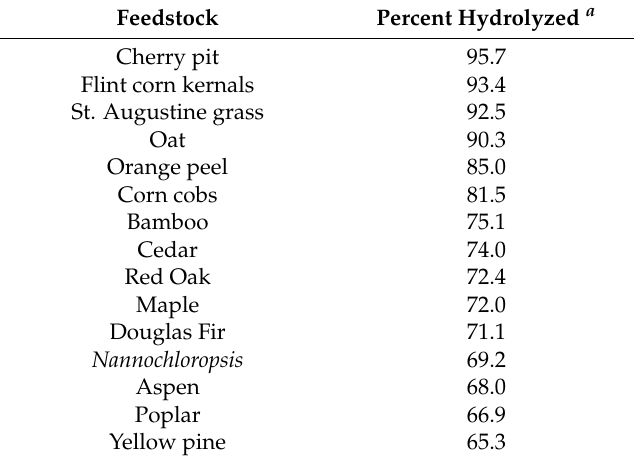
Table 1. Waste materials containing cellulose that can be converted into simple